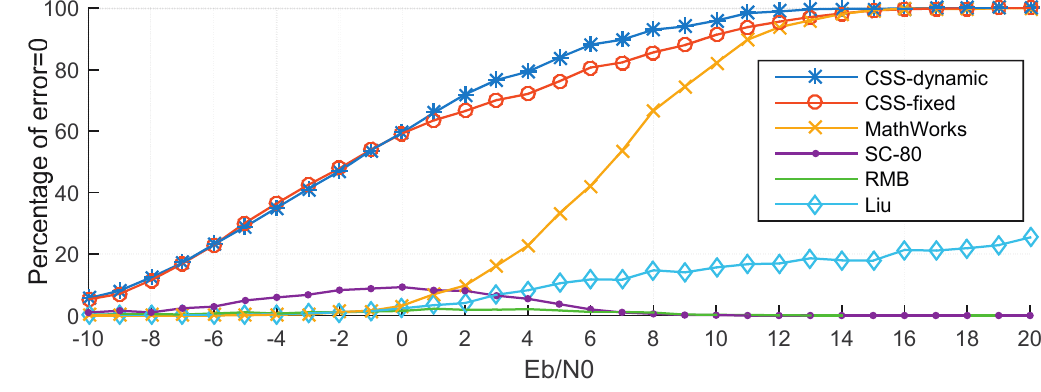
Figure 15. Percentage that the timing error is zero in ITU channel.